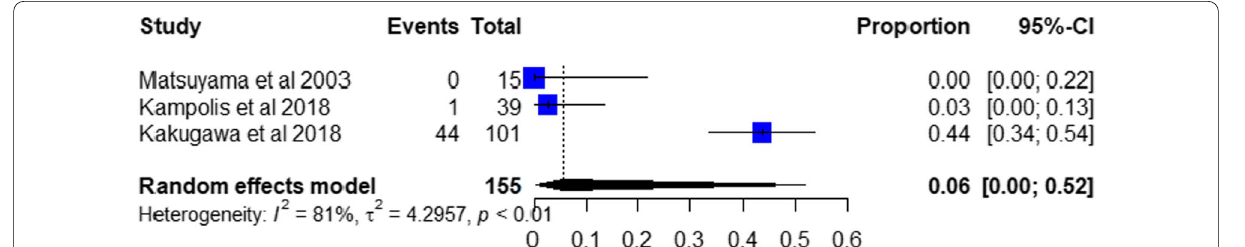
Fig. 11 Meta‑analysis of the Bronchiectasis in patients with Sjogren’s